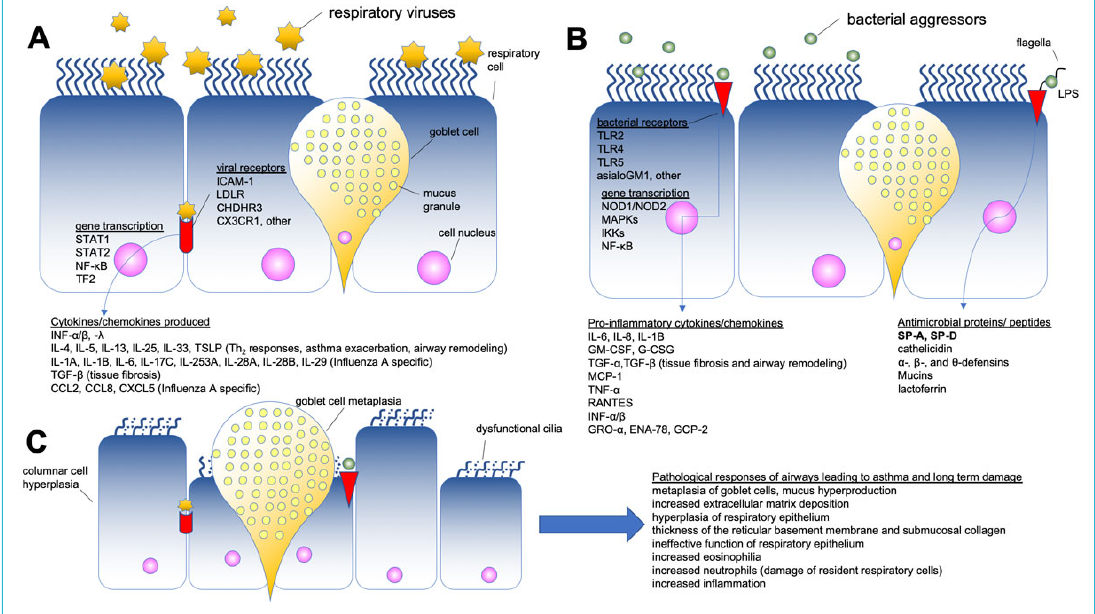
Figure 1: The model shows the major molecular pathways of airway innate immunity and provides information on the causality on unified air- way disease. Panels A and B show the major mechanisms deployed by respiratory viruses and bacterial aggressors, respectively, how ag- gressors enter the respiratory epithelium, and the defence reactions of the cells (production of cytokines/chemokines and antimicrobial pro- teins/peptides). Panel C depicts the pathological responses of the epithelium to airway remodelling and long-term damage that becomes independent of any ongoing